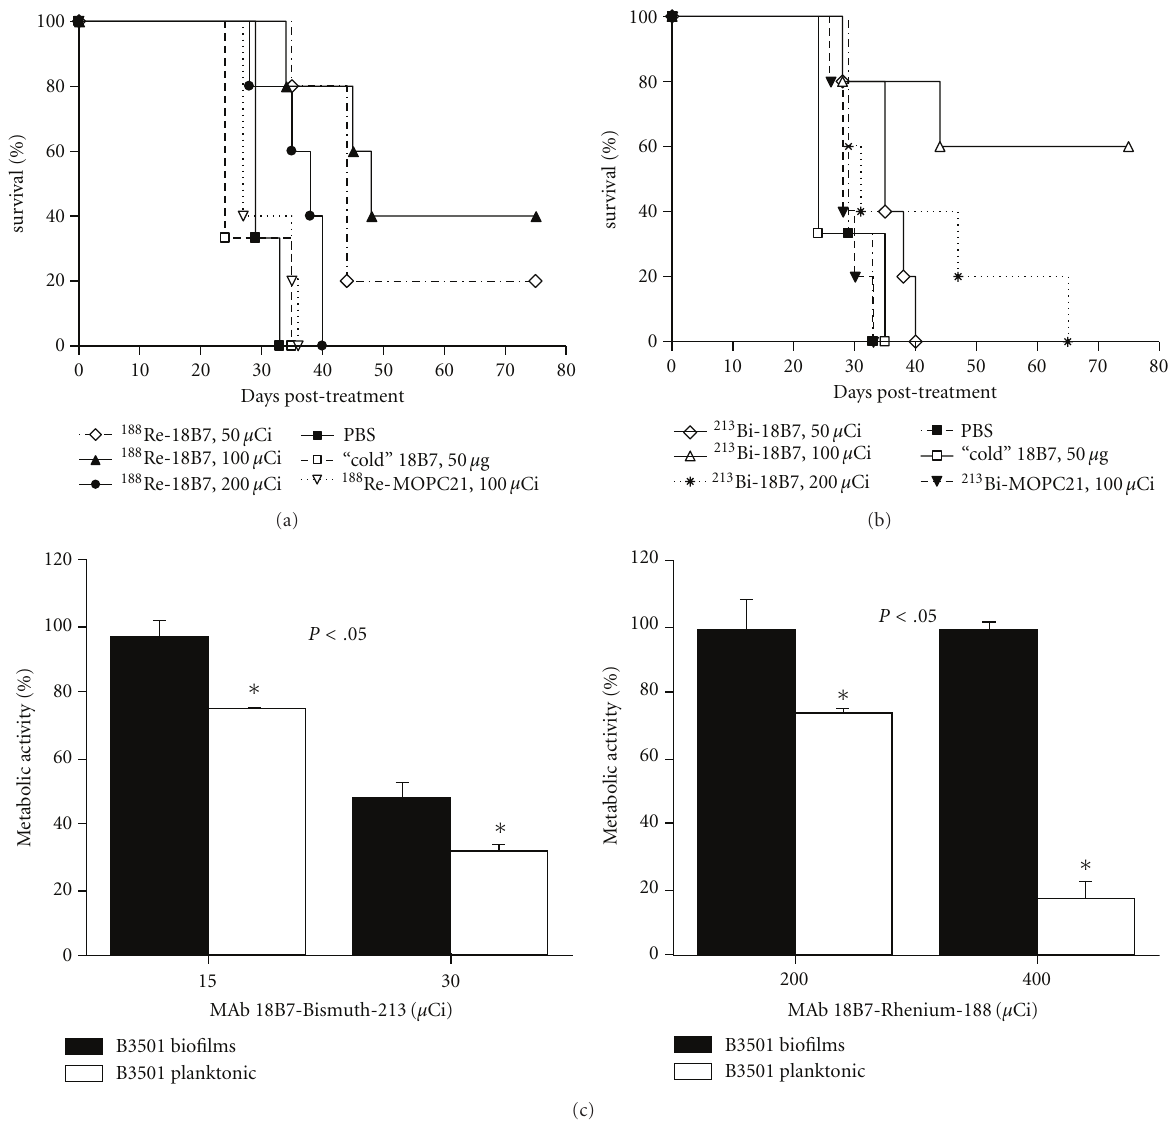
Figure 1: E ffi cacy of RIT of CN with 213 Bi- and 188 Re- labeled mAbs: (a, b) Kaplan-Meier survival curves for A/JCr mice infected IV with 10 5 C. neoformans cells 24hr prior to treatment with 50–200 μ Ci 188 Re- (a) or 213 Bi-labeled (b) mAbs. Animals injected with PBS (phosphate bu ff ered saline) or 50 μ g “cold” 18B7 served as controls; (c) treatment of CN biofilms in vitro with 213 Bi- (left panel ) or 188 Re- (right panel) labeled 18B7 mAb; adapted from [3,